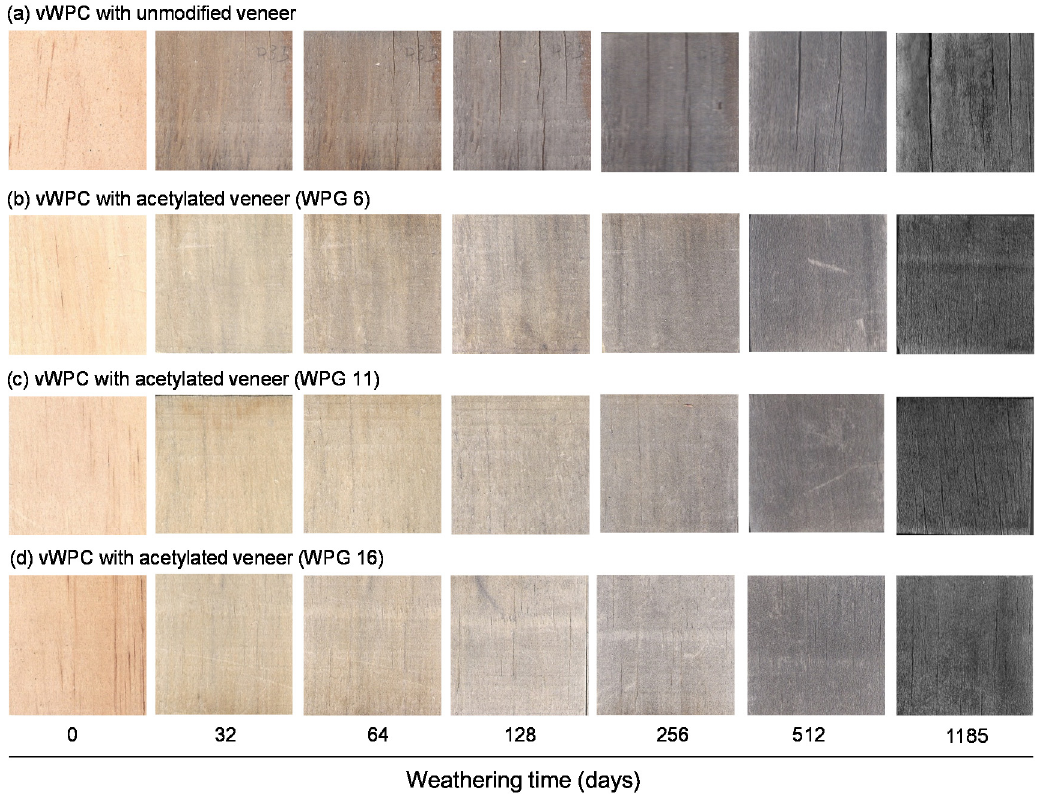
Figure 2. Surface images of vWPCs with unmodified veneers ( a ), WPG 6 ( b ), WPG 11 ( c ), and WPG 16 ( d ) acetylated veneers during 1185 days of natural weathering.